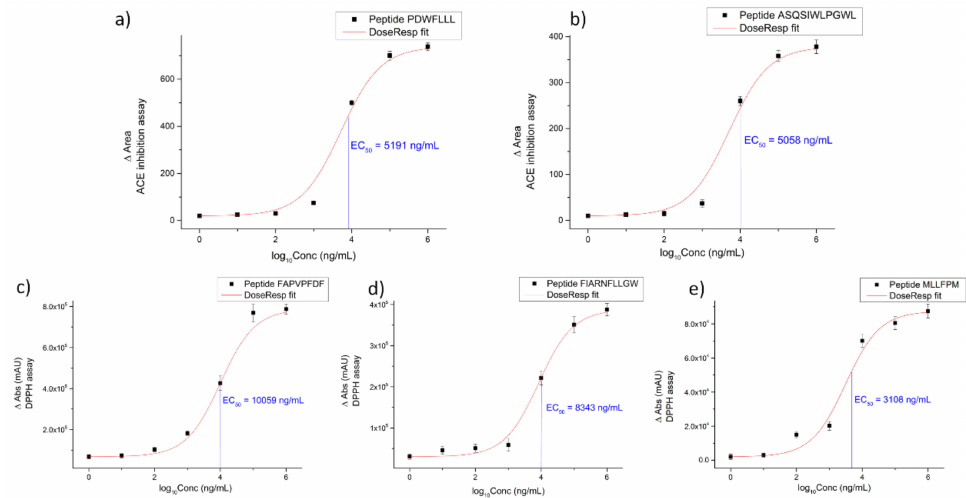
Figure 2. Graphs reporting the EC50 values of the peptides that resulted as bioactive in the in vitro ACE-inhibitory assay ( a , b ) and DPPH assay ( c , d , e